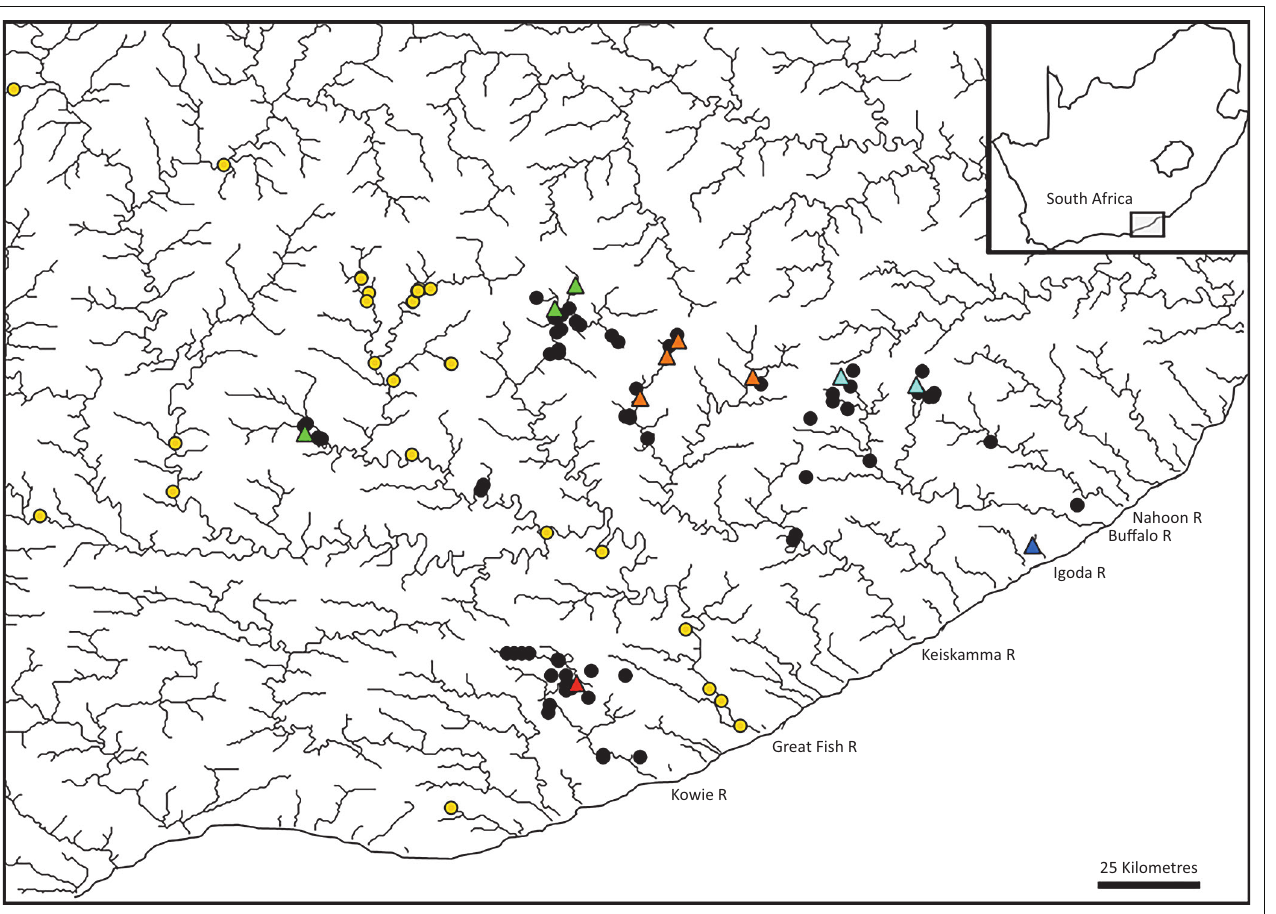
NRF, National Research Foundation; SAIAB, South African Institute for Aquatic Biodiversity. FIGURE 1: Historical distribution of the Eastern Cape rocky, Sandelia bainsii , based on records from the National Fish Collection at the NRF-SAIAB (black circles), the localities where tissues samples were collected from the Kowie (red triangle), Great Fish (green triangles), Keiskamma (orange triangles), Igoda (turquoise triangle) and Buffalo (navy blue triangles) river systems. The yellow points represent localities where Sandelia bainsii was not recorded from recent surveys